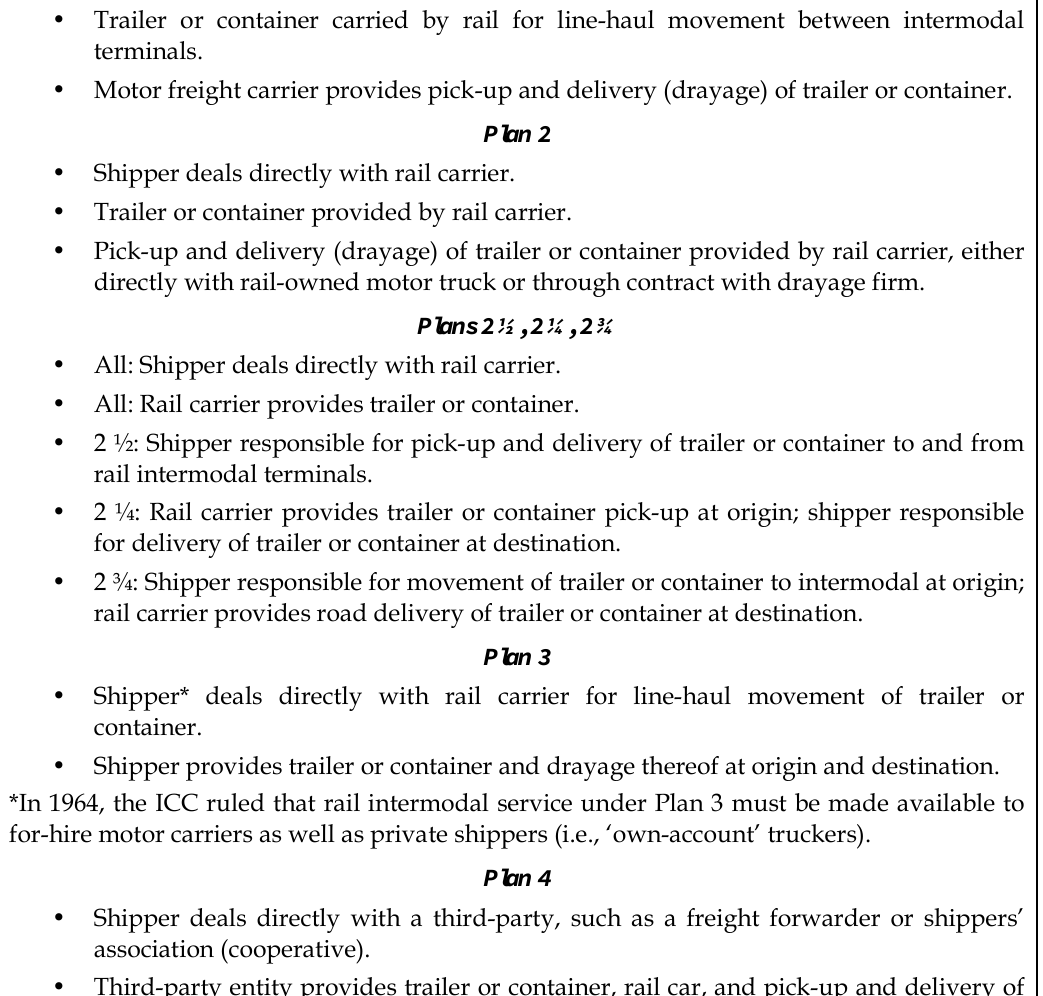
Figure 2.Intermodal Rail Freight Service Plans Sources: I.C.C., Movement of Highway Trailers by Rail , docket No. 31375, decided July 30, 1954; Ex Parte No. 230, Substituted Service – Piggy-Back, 332 ICC 301, quoted in Locklin, 1966, pp.